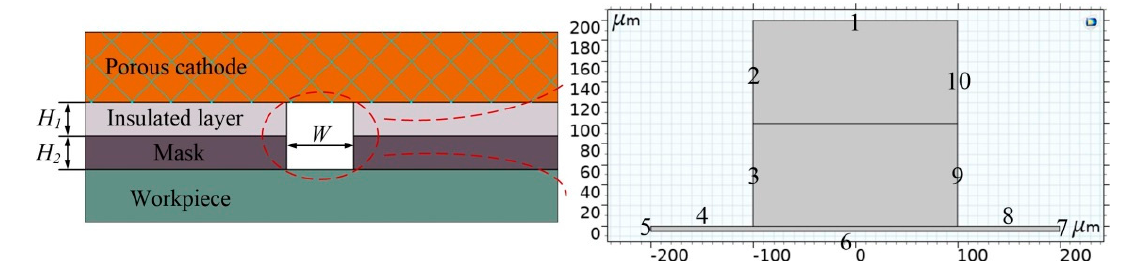
Figure 2. The 2D model of electrochemical machining (ECM) with a masked porous cathode.